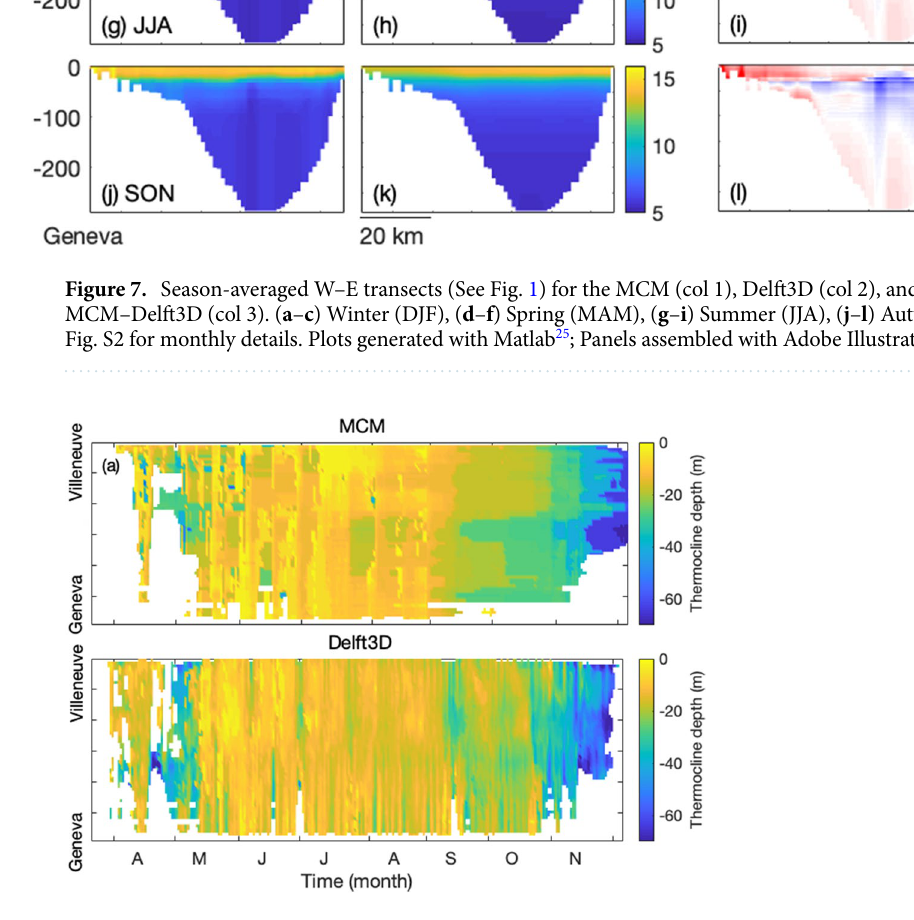
Figure 8. Temporal evolution of the thermocline depth over the the W–E transect, as simulated by ( a ) the MCM and ( b ) Delft3D. Plots generated with Matlab 25 ; Panels assembled with Adobe Illustrator 26